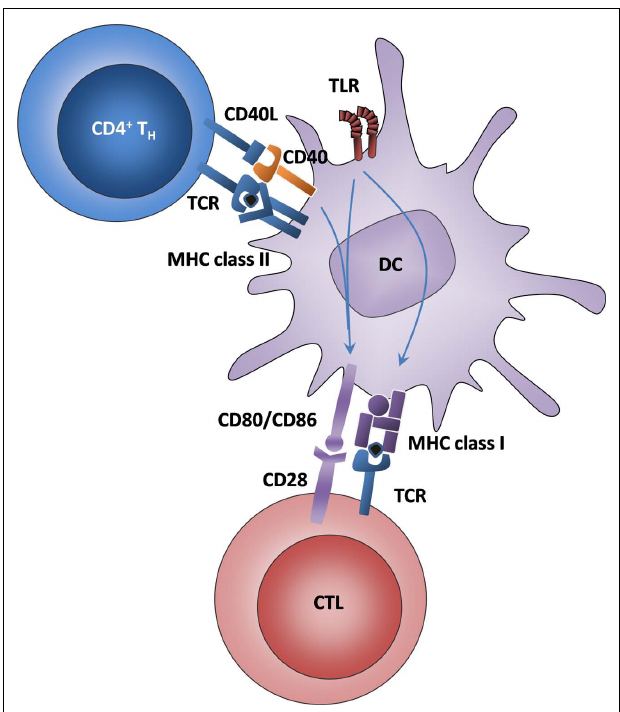
FIGURE 1 | Classical DC licensing for cross-priming is mediated byTh cells and enhanced byTLR ligands. DCs interact withTh cells via antigen that is presented on MHC class II and recognized by theTCR and via CD40–CD40L interactions.The signals downstream of CD40 andTLRs lead to the upregulation of MHC class I and CD80/86, thus allowing the DC to interact with